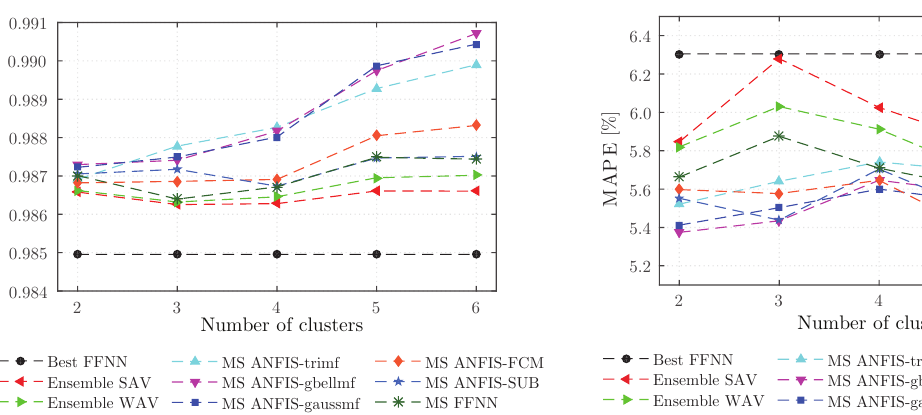
Figure 9: R 2 for different cluster number for training